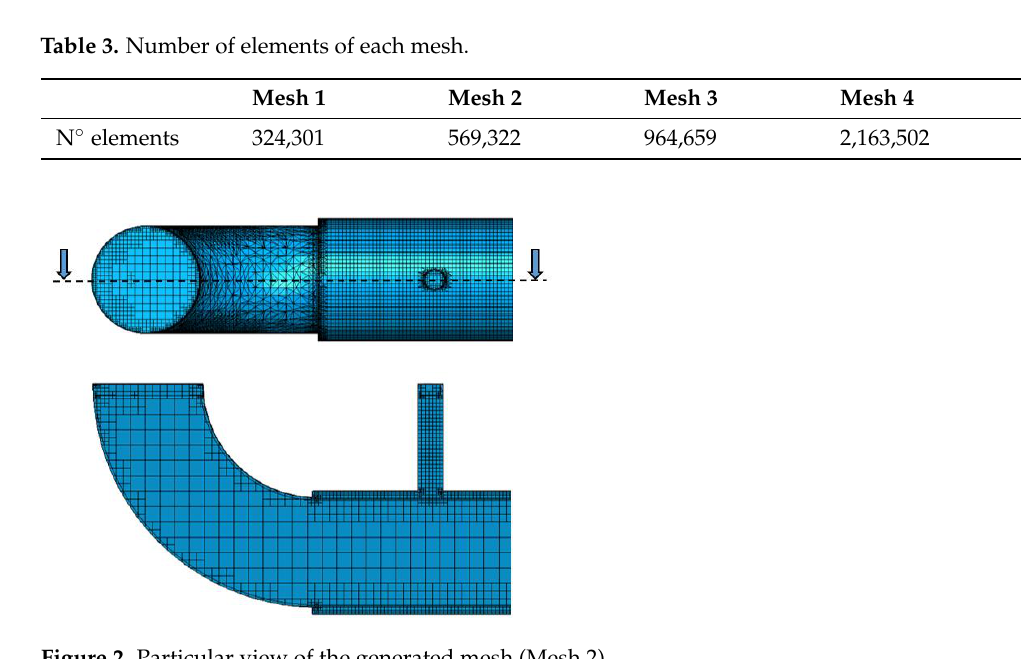
Figure 2. Particular view of the generated mesh (Mesh